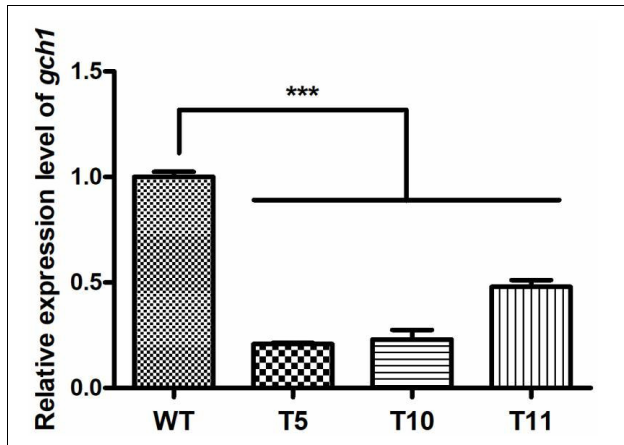
FIGURE 5 | The expression level of cagch1 in mature fruiting bodies. Asterisks (***) indicate the data that differed significantly based on p < 0.0001 ( t -test) as the significance threshold.